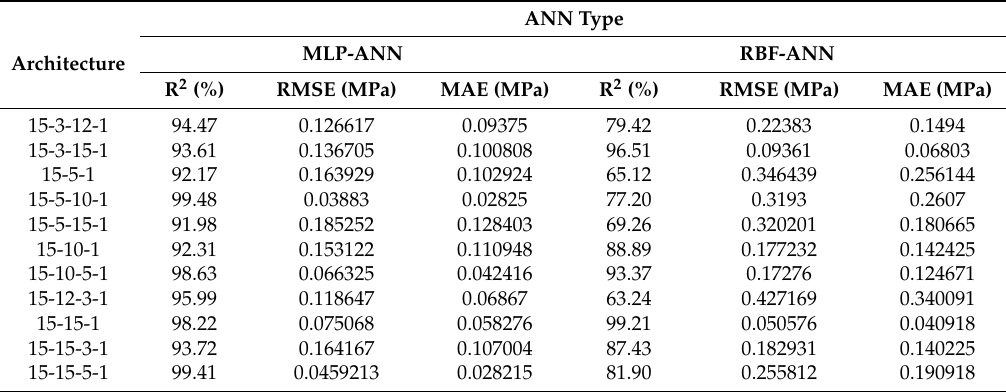
Table 3. Performance of different multi-layer perceptron (MLP) and radial basis function (RBF) artificial neural networks (ANNs) in the prediction of the P i for the testing data series (Mohr–Coulomb case).